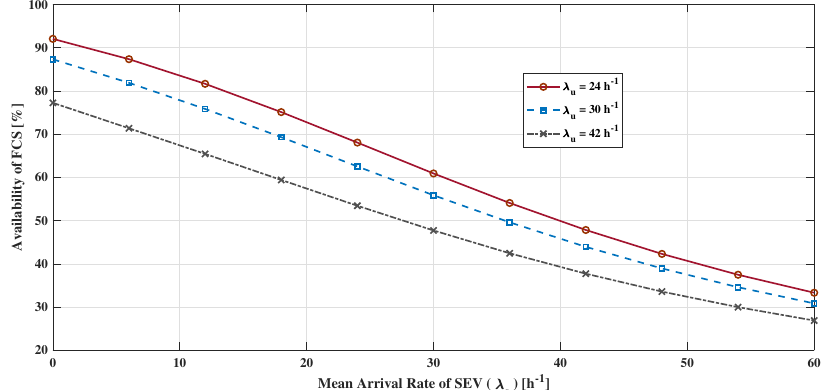
Figure 6. Availability of FCS for UEVs as a function of λ s